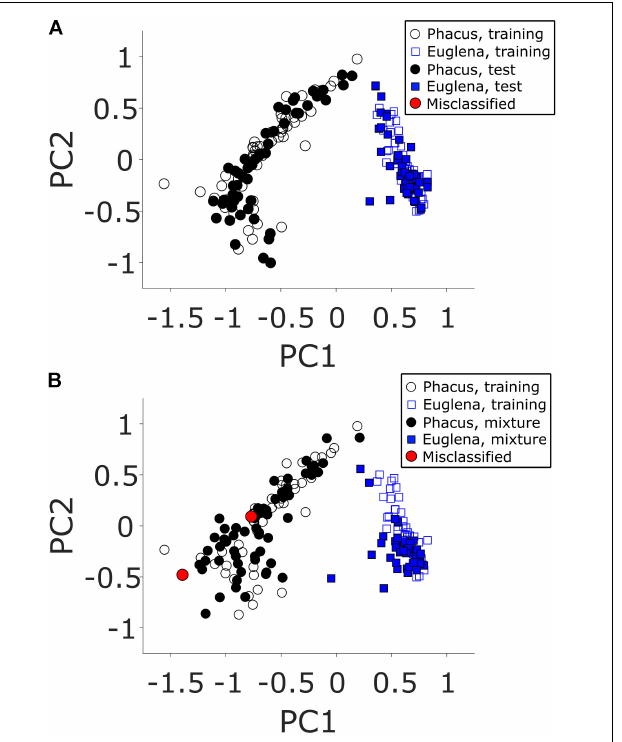
FIGURE 4 | Two-component PCA models of positive mode ESI-MS TOF mass spectra for samples derived from analyses of (A) unmixed and (B) mixed ( blue squares ) Euglena gracilis and ( black circles ) Phacus algae cells. Open circles and squares represent the training samples (from analyses of unmixed cells in both panels) used to generate the PCA-LDA model. Red circles represent incorrectly classified test